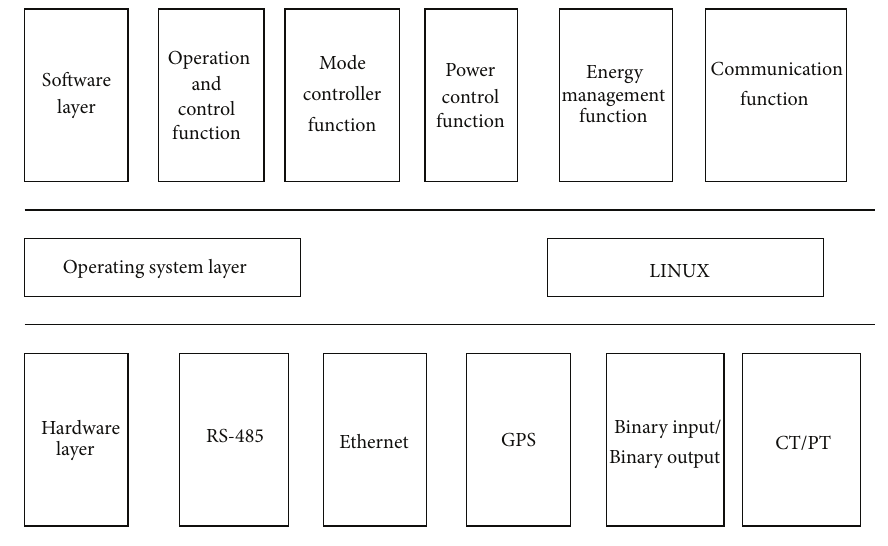
Figure 9: The operation and control device of microgrid.